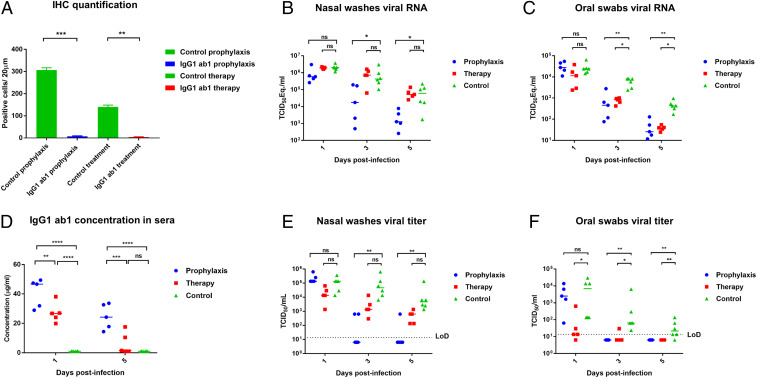
Quantification of IHC, measurement of IgG1 ab1 concentration in hamster sera postvirus challenge, and detection of infectious virus and viral RNA in hamster shedding including nasal washes and oral swabs. (A) Quantification of IHC image. IHC was quantified using ImageJ software by counting positive cells at 40× magnification (unpaired, two-tailed Student’s t test. **P < 0.01, ***P < 0.001). (B, C, E, and F) Detection of infectious virus and viral RNA in hamster nasal washes and oral swabs. Nasal washes and oral swabs were collected at day 1, 3, and 5 postinfection (dpi) for virus titer titration by TCID50 assays and viral RNA quantification by RT-qPCR. (B and E) Nasal washes viral RNA and viral titer in untreated, pretreated, and posttreated hamsters (Kruskal–Wallis followed by Dunn’s test, ns: P > 0.05, *P < 0.05, **P < 0.01). (C and F) Oral swab viral RNA and viral titer in untreated, pretreated, and posttreated hamsters (Kruskal–Wallis followed by Dunn’s test, ns: P > 0.05, *P < 0.05, **P < 0.01). (D) IgG1 ab1 concentration in hamster sera when administered prophylactically and therapeutically. Hamsters were bled at 1 and 5 dpi for measuring antibody concentrations in sera by SARS-CoV-2 S1 ELISA (two-way ANOVA followed by Tukey’s test, ns: P > 0.05, **P < 0.01, ***P < 0.001, ****P < 0.001).